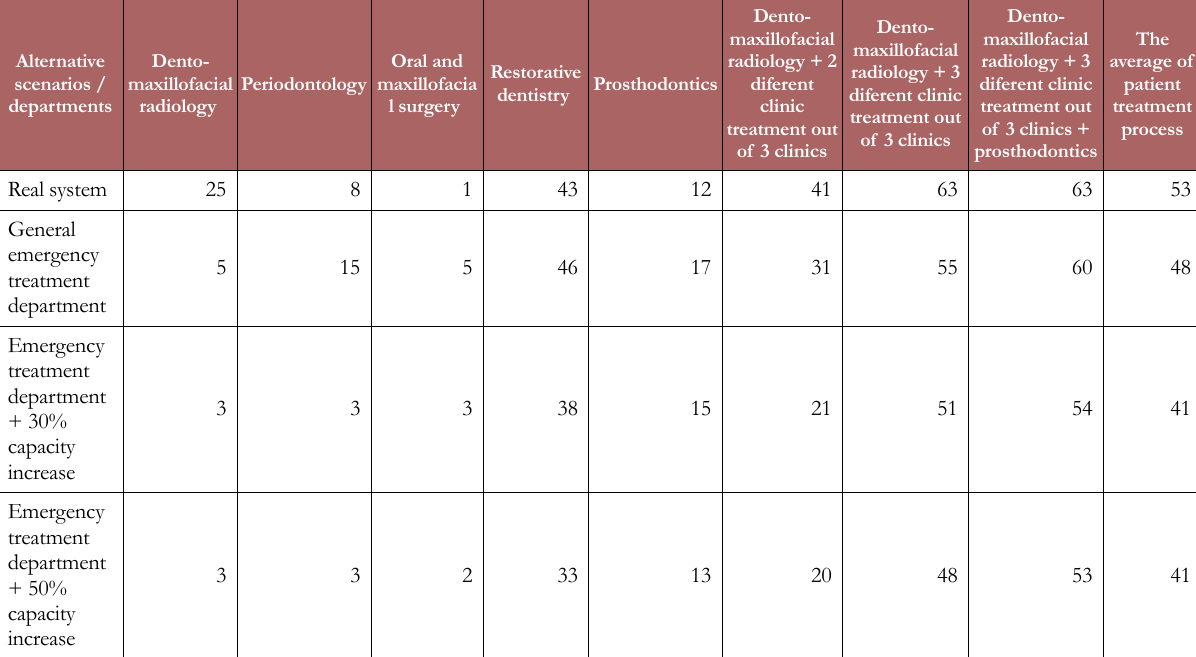
Table 3. The impact of alternative scenarios which on the number of treatment